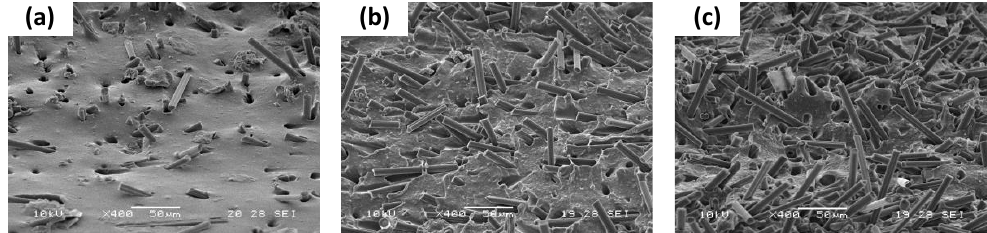
Figure 3. Cryo-fracture surface carbon fibre/silicone composites containing carbon fibre. (a) 5 vol%, (b) 15 vol% and (c) 20 vol%.